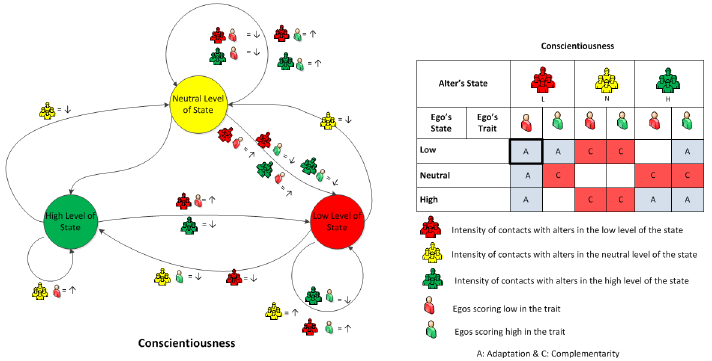
Fig 2. (Left) Transition graph for conscientiousness: Nodes represent conscientiousness level of the ego. Arrows represent transitions from one level to another. Transitions are labeled with conditions that affect the corresponding probabilities. Icons represent the conscientiousness levels of alters and ego ’ s trait level. Symbol " (respectively # ) indicates an increase (respectively decrease) in transition probability associated with the given combination of alters ’ state level and ego ’ s trait level. For example, if the ego high in the conscientiousness state, then the probability of the ego transitioning to the high level decreases with ego ’ s contact with alters in the neutral level of the state. Another example is the transition from neutral to low level of conscientiousness, which is moderated by the ego ’ s trait score. If the ego is high in trait, then the probability of transition from a neutral state to a low state decreases with his contact with alters in high and low levels. But if the ego is low in the trait, then the probability increases instead. (Right) Social influences: The table summarizes the level transition graph by means of adaptation (A) and complementarity (C). Rows represent ego ’ s state levels; columns are labeled with alters ’ state levels and sub-labeled with ego ’ s trait level (Low or High). Cells report the effects observed when egos in the corresponding state level and trait level interact with alters in the corresponding state level. For example, the square with thick border indicates that when the ego is low in conscientiousness state and also low in conscientiousness trait, contact with alters who are also low in conscientiousness state results in an adaptation effect. Empty cells lack statistically significant effects in a given combination.